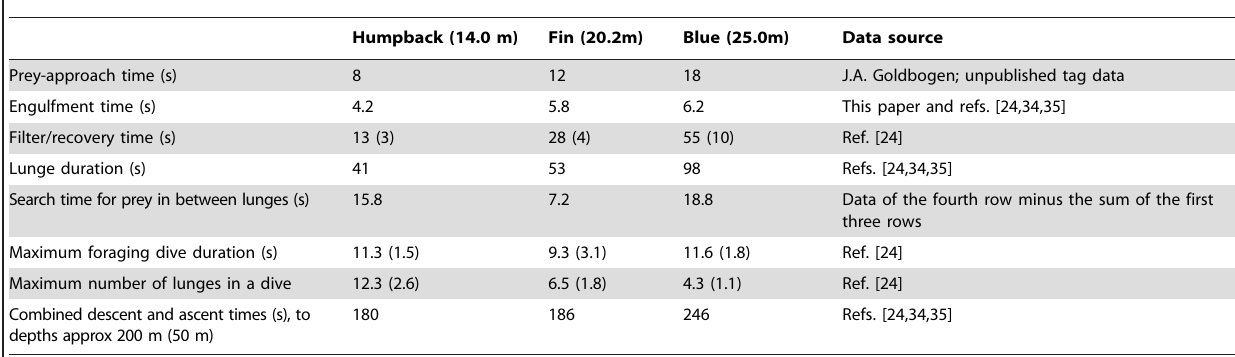
Table 5. Foraging durations from tag data.